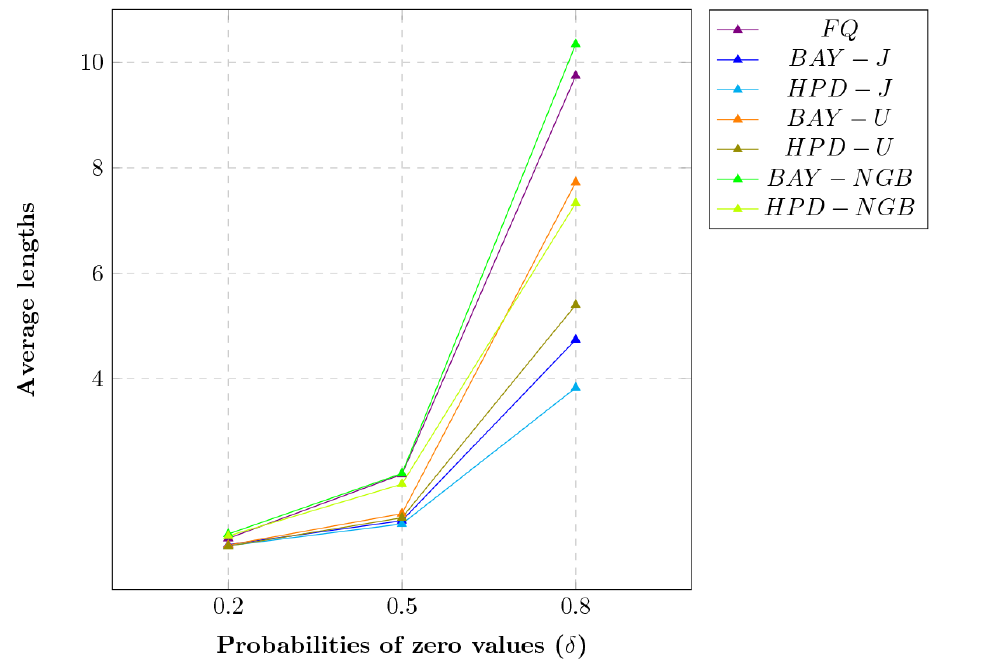
Figure 4. Line graphs of the ALs of the methods in the simulated scenario with different probabilities of zero